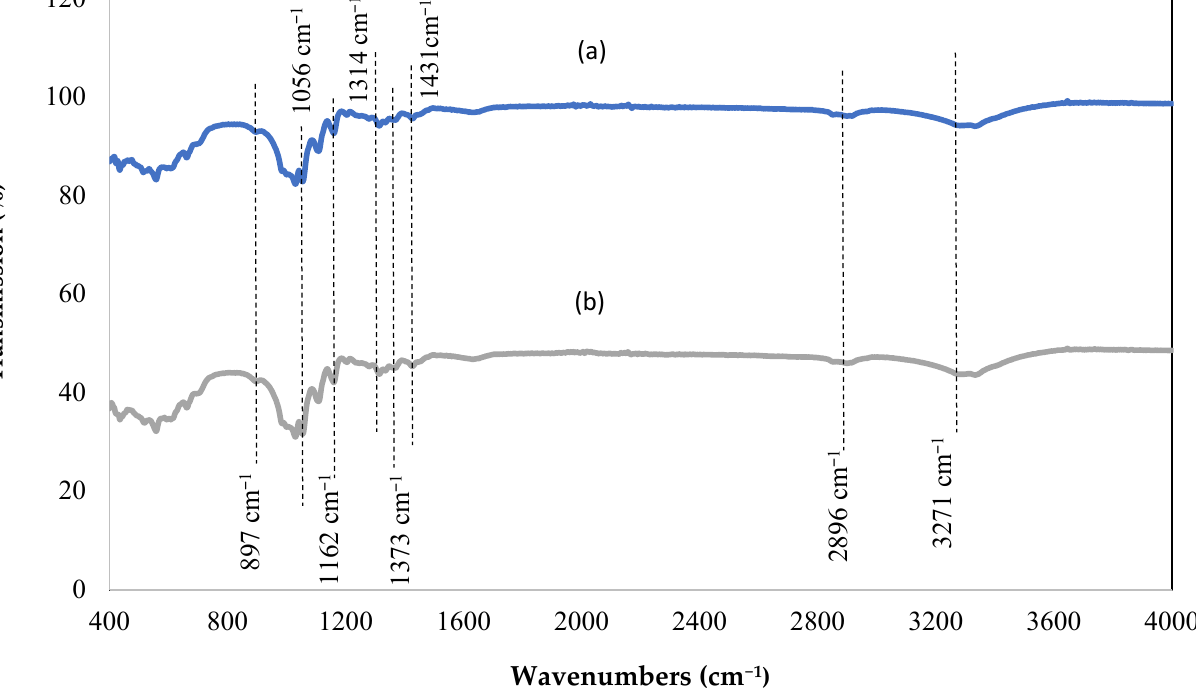
Figure 2. ATR-FTIR spectra of ( a ) untreated cotton and ( b ) plasma treated cotton. Characteristic peaks at 1431 and 1373 cm − 1 are attributed to bending vibrations of methyl and ethyl groups ν (CH 3 ) and ν (CH 2 ) [38]. The peaks at 1314, 1162–1056 and 897 cm − 1 are assigned to C–O stretching of ether, C–O–C stretching, and glycosidic C-H deformation, respectively [39,40]. The spectrum of cotton fabrics before plasma treatment did not show any significant difference when compared to the untreated fabric. This outcome is due to the high penetration depth (around 1 μ m) of ATR-FTIR analysis. This depth